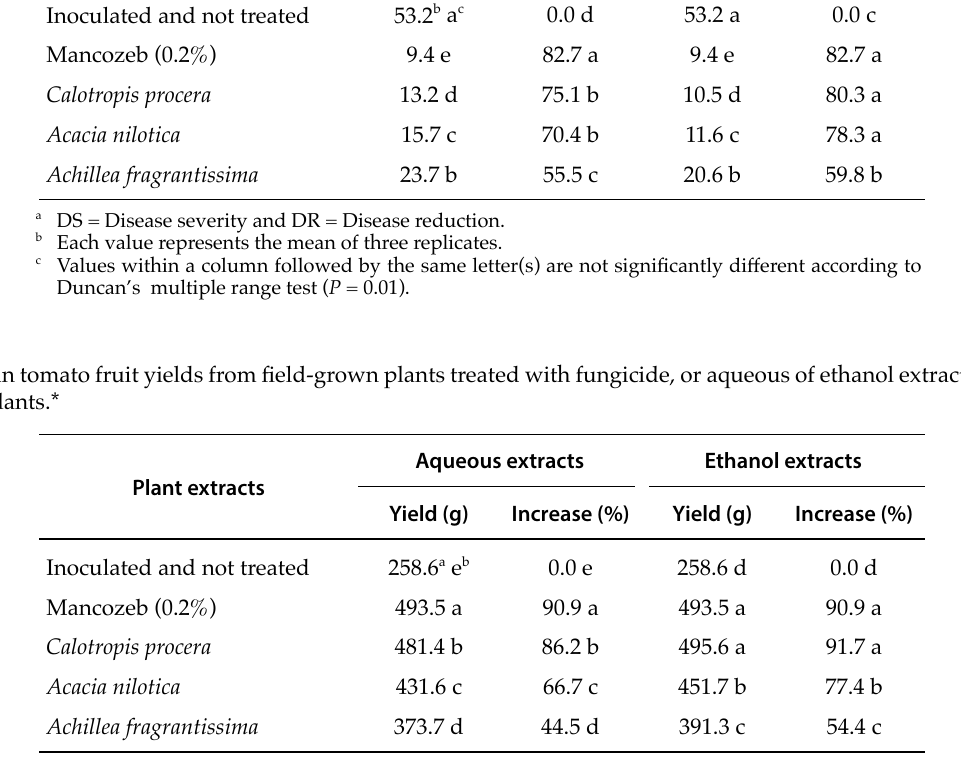
a Each value represents the mean of three replicates. b Values within a column followed by the same letter(s) are not significantly different according to Duncan’s multiple range test ( P =